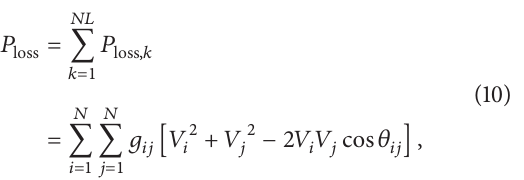
algorithm, JA-ABC5. The mathematical formulation of